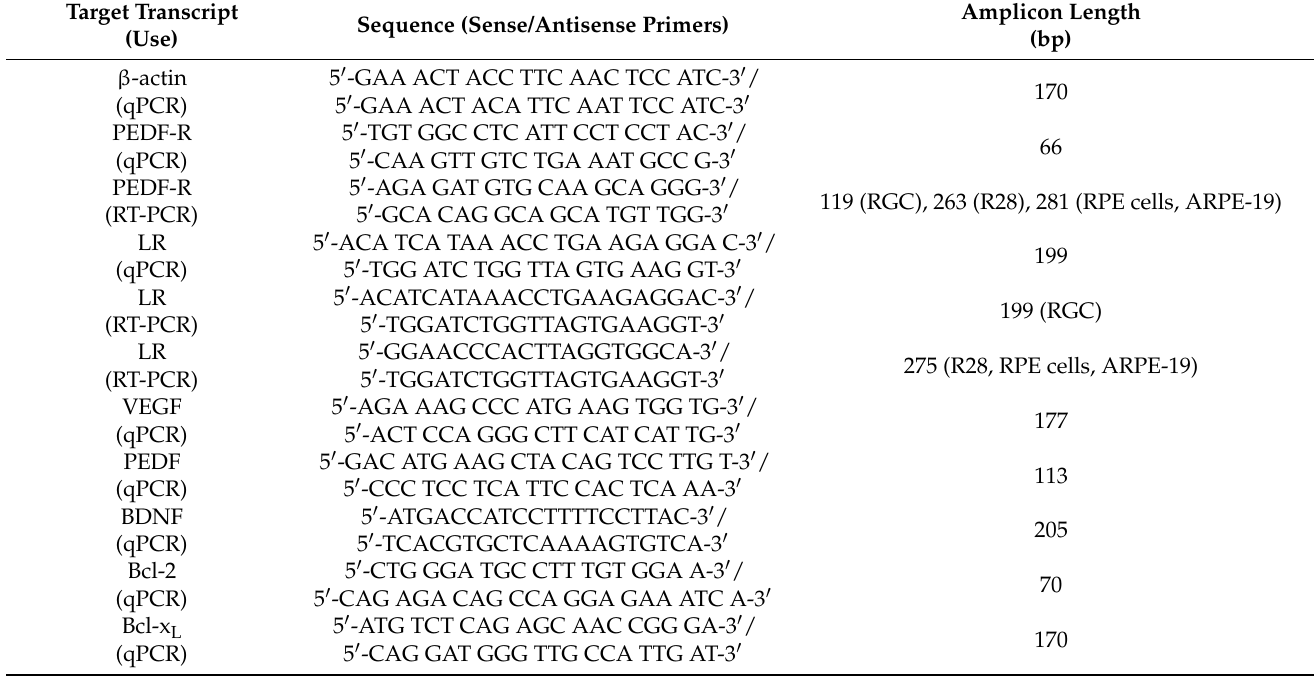
Table 1. List of oligonucleotides used for PCR